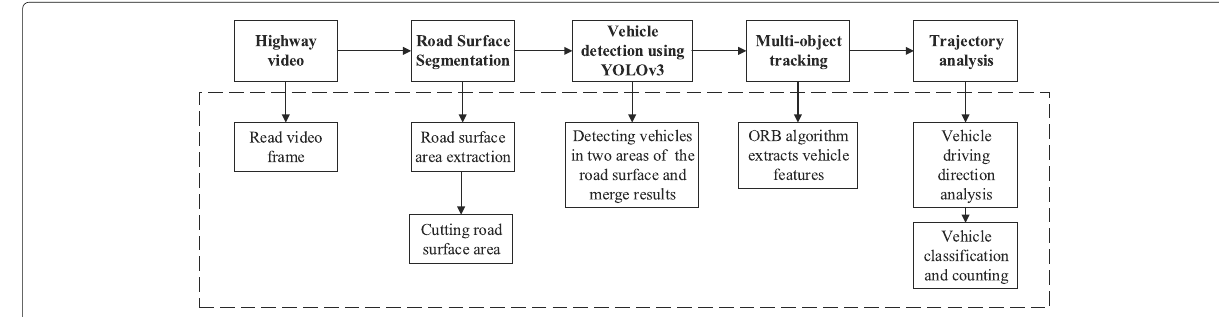
neutralize the colour with a similar colour distribution, and erode the colour area with a smaller area. On this basis, the flooding filling algorithm is used to separate the road surface area. The flooding filling algorithm selects a point in the road surface area as a seed point and fills the adjacent continuous road surface areas with the pixel value of the seed point. The pixel value of the